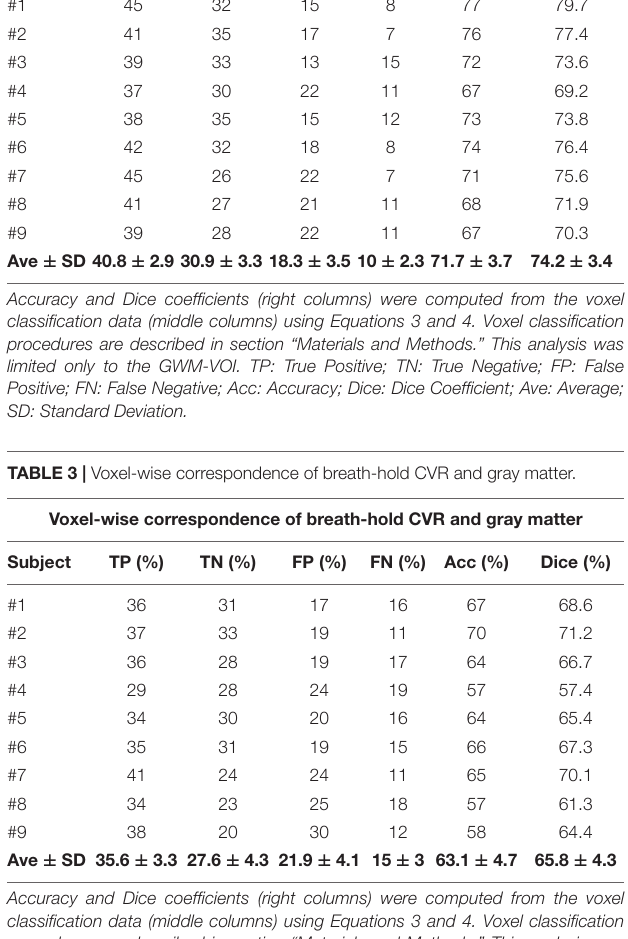
TABLE 2 | Voxel-wise correspondence of resting-state CVRe and gray matter. Voxel-wise correspondence of resting-state CVRe and gray matter